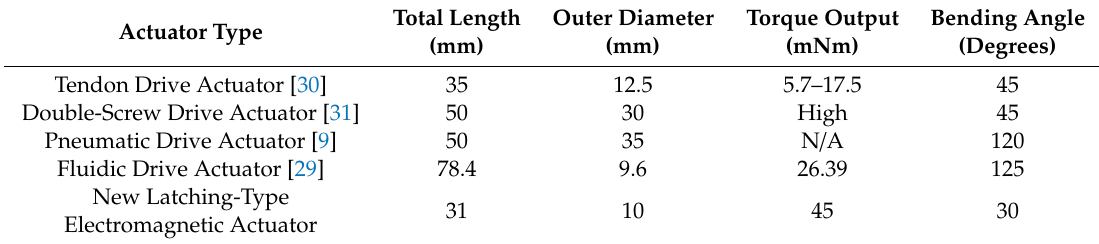
Table 5. Performance of di ff erent actuators proposed for single-port laparoscopic surgery (SLS)